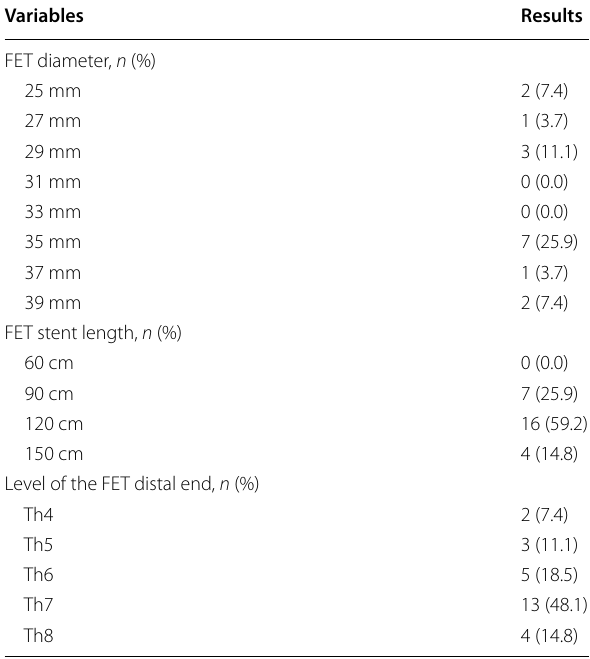
Table 2 Details of frozen elephant trunk grafts ( N